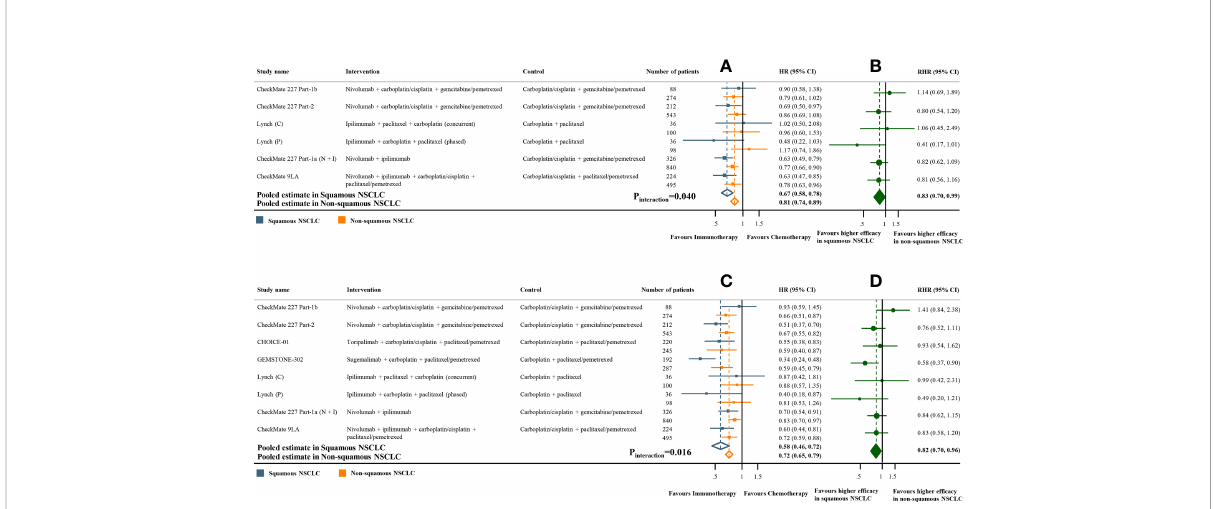
FIGURE 4 Overall and progression-free survival bene fi ts of ICI-based combination treatments compared with chemotherapy in studies with paired subgroups. (A) HRs of overall survival according to histology. (B) Trial-speci fi c ratios of the HR in SQ-NSCLC to the HR in non-SQ-NSCLC (RHR). (C) HRs of progression-free survival according to histology. (D) Trial-speci fi c ratios of the HR in SQ-NSCLC to the HR in non-SQ-NSCLC. ICI, immune checkpoint inhibitor; HR, hazard ratio; RHR, ratios of the HRs; CI, con fi dence